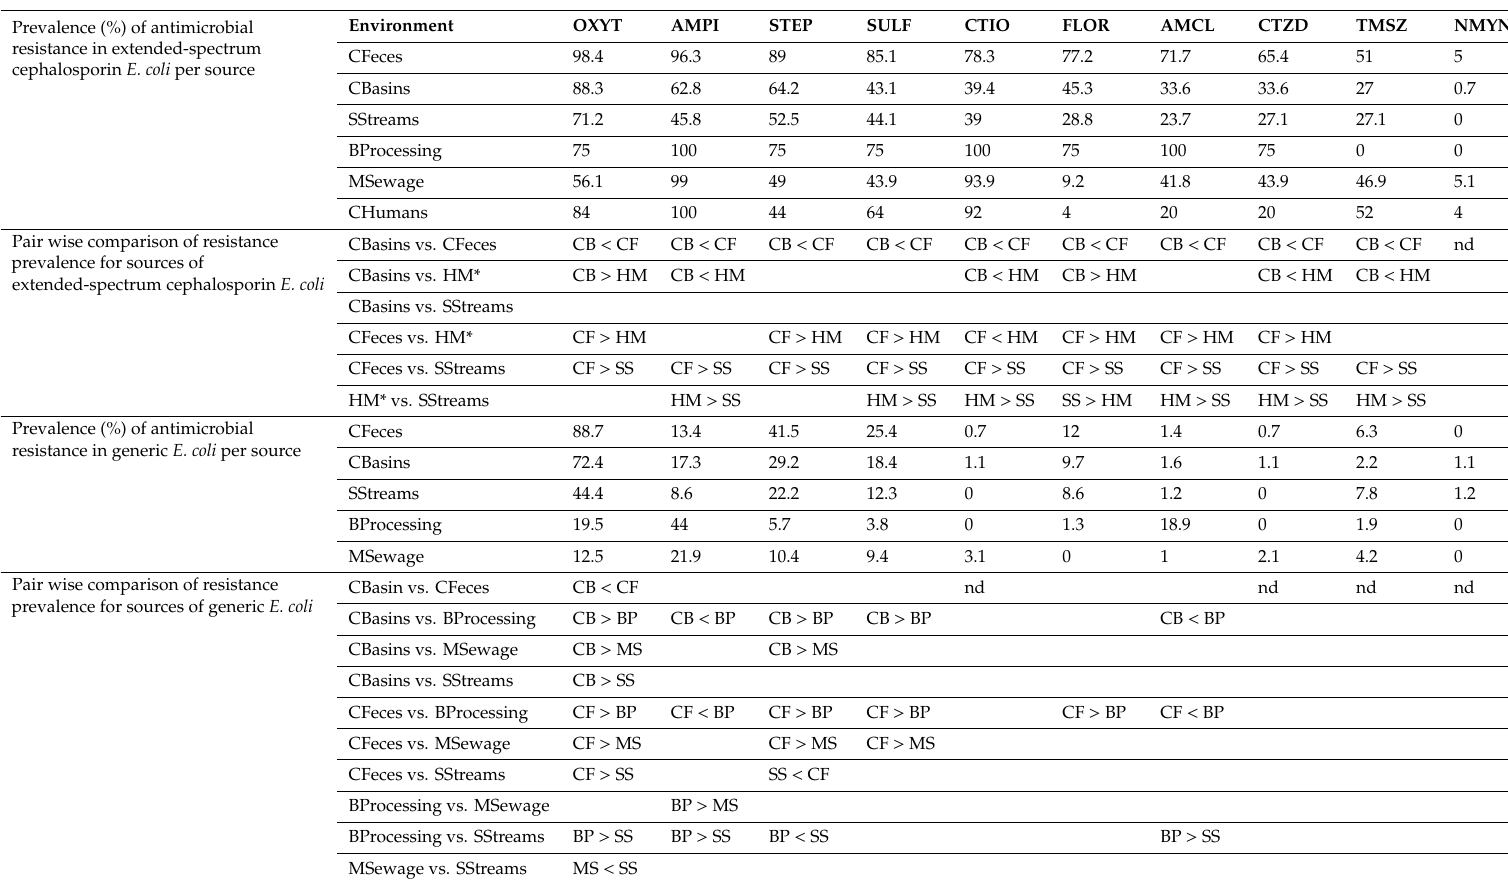
Table 1. Trends of antimicrobial resistance prevalence in extended-spectrum cephalosporin-resistant E. coli (ESC r ) and generic E. coli populations with specificity to sample origin, expressed as percentages. Prevalence (%) of antimicrobial resistance in extended-spectrum cephalosporin E. coli per source